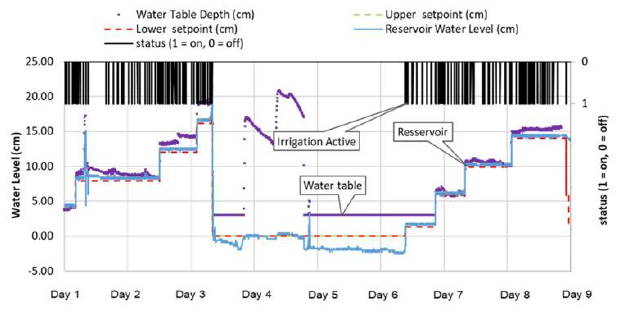
Fig. 6 Irrigation activity, controlled water levels and water table at the reservoir, over the sheet pipe, and center of the soil, 0 cm equals Z=15cm; 25 cm is the top of soil (z =